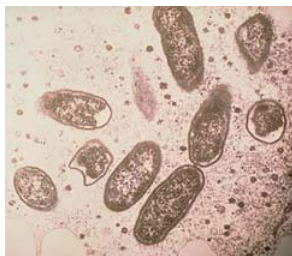
Figure 1. Electron microscopy of Rickettsia rickettsii